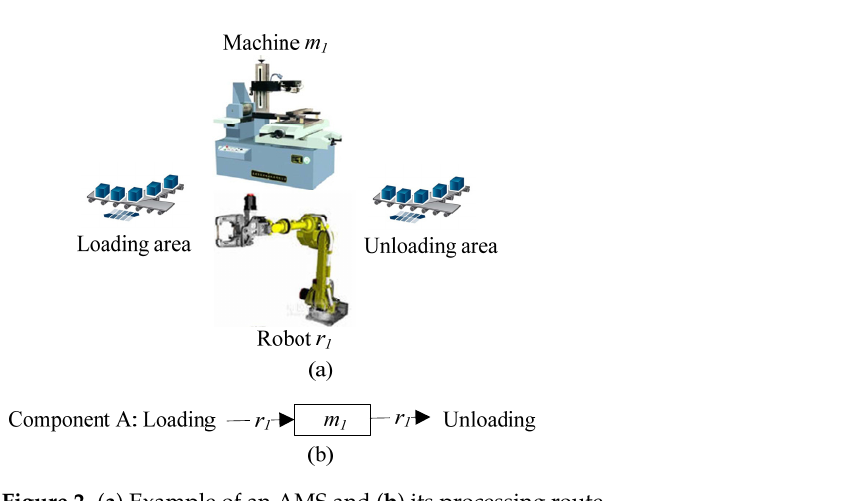
Figure 4. CROPN model based on IoT for the system presented in Figure 3. In [33], a high-speed data acquisition board with a maximum sampling rate of 100 kHz was used to transmit the data. The output of the sampled data was utilized by the signal processing software. Multiple sensor signals were preprocessed. In most instances, the signal was amplified to meet equipment threshold requirements. Specifically, the data from the “acoustic emission sensors” and the “vibration sensors” were amplified to be within the range of ±5 V for maximum load, taking into account the equipment’s maxi- mum permitted range. The signals were screened using a “high-pass filter”, and the “vi- bration sensor” signals were further screened using a “low-pass filter”. The corner fre- quencies were selected based on the noise noticed on an “oscilloscope”. On the oscillo- scope, 180 Hz of periodic noise was observed for the vibration signal, matching the third